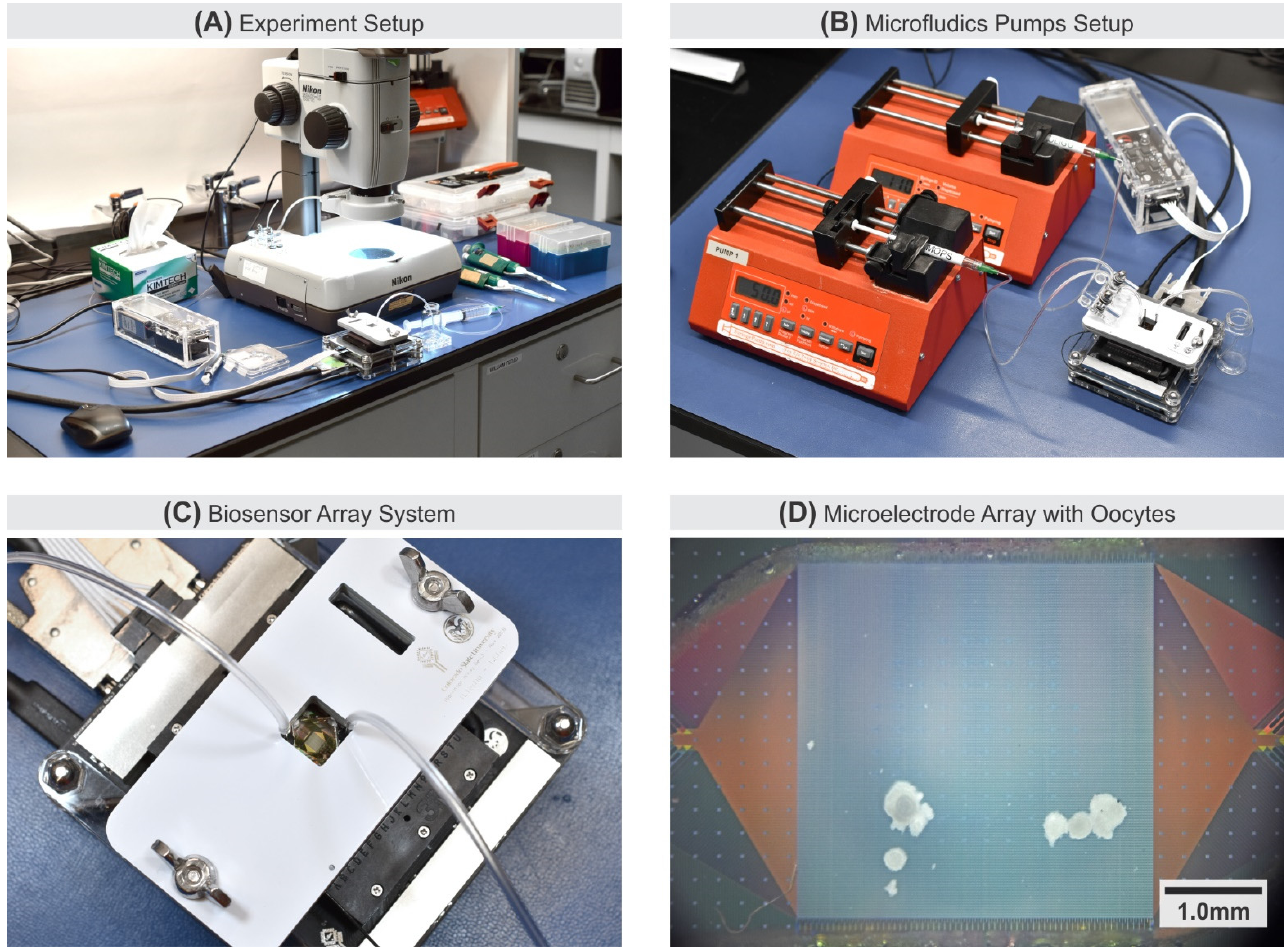
Figure 3. Electrochemical sensor with microfluidic system. ( A ) Typical In vitro experiment setup employing a stereomi- croscope. ( B ) A setup employing two syringe pumps for simultaneous delivery of two types of solutions. ( C ) A close-up system setup showing the clear microfluidic PMMA cover with integrated ITO-coated glass, and an opening in the pressure plate allowing optical imaging of the MEA area. ( D ) An image from the stereomicroscope depicting loaded COCs to the MEA surface.